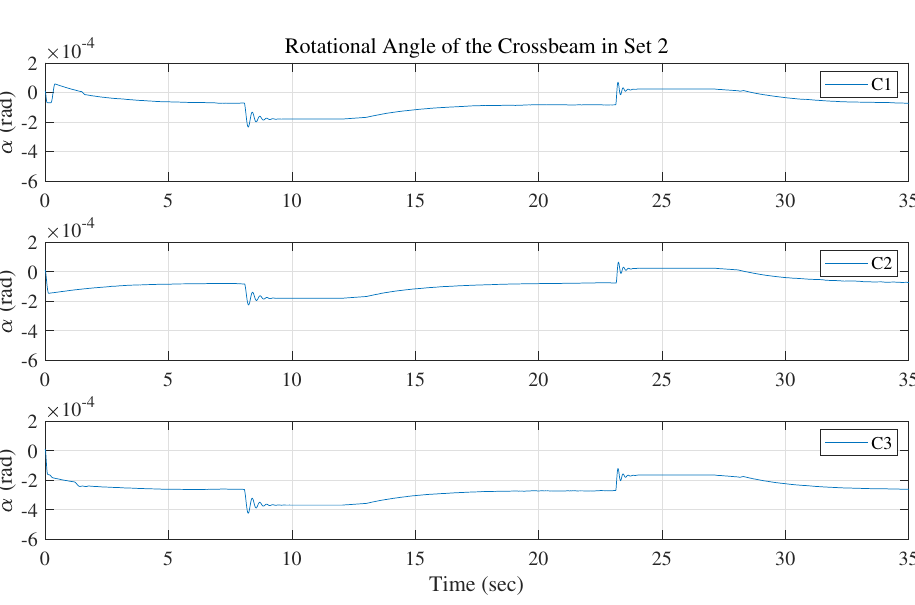
Figure 12. Rotational angles comparison in Set 1.